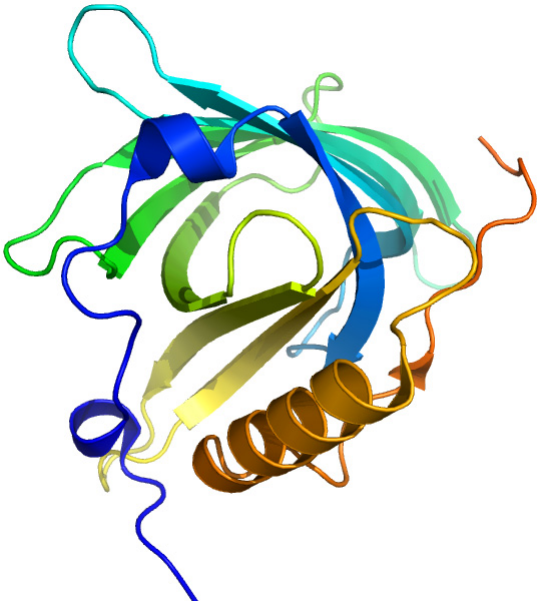
Figure 7. Crystal structures of the human plasma retinol binding protein. The illustration was produced by PyMol using the atomic coordinates from the Protein Data Bank, PDB1JYD [54].